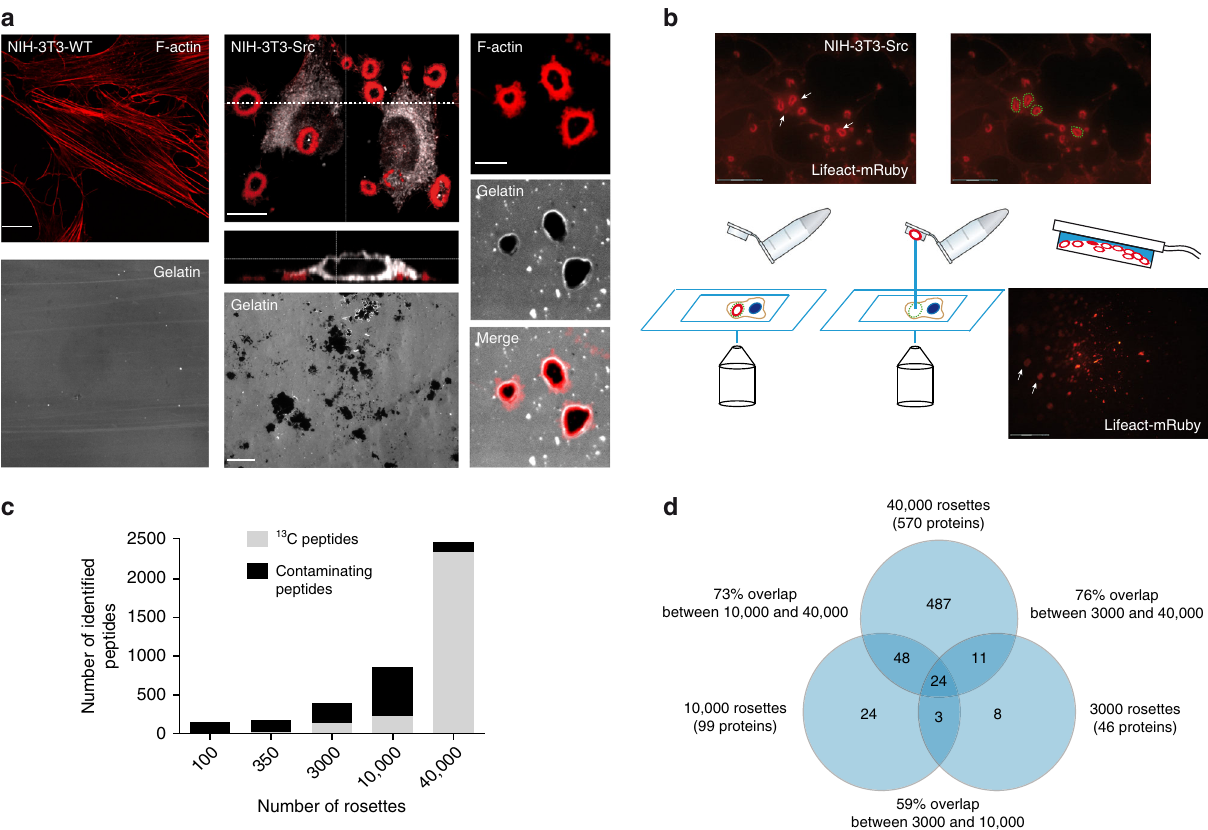
Fig. 1 Laser capture and collection of rosettes, global identi fi cation values and reproducibility of identi fi cation. a Left panel: representative confocal images of NIH-3T3 wild-type (WT) cells presenting only stress fi bers when seeded on a fl uorescent gelatin matrix (as seen in the image below). a Middle panel: representative confocal images of NIH-3T3-Src cells with invadosome rosettes revealed with the Lifeact-mRuby (red). Orthogonal view section shows the thickness of those structures. Below, a representative image of an in situ zymography assay shows the degradation capacity of the cells when seeded on a fl uorescent gelatin matrix. Scale bars: 10 µ m. a Right panel: representative confocal images of rosettes degrading the fl uorescent gelatin matrix. Scale bars: 10 µ m. b Upper panel: representative confocal images of NIH-3T3-Src cells with rosettes. In the right image, the dotted circles surround the rosettes that were microdissected (scale bar: 30 µ m); b lower panel: schematic representation of the microdissection process. The laser cuts the region of interest, which will then be propelled into the cap of a tube. The last panel shows microdissected rosettes (Lifeact-mRuby, red) collected into the cap of the tube (scale bar: 300 µ m). c Number of identi fi ed peptides according to the number of collected rosettes. Due to previous metabolic isotopic labelling, peptides coming from dissected invadosomes were identi fi ed with 13 C modi fi cations ( 13 C peptides) and discriminated from external contamination (contaminating peptides). d Proteins identi fi ed in each experiment (increasing number of collected invadosomes) were compared with estimate the reproducibility